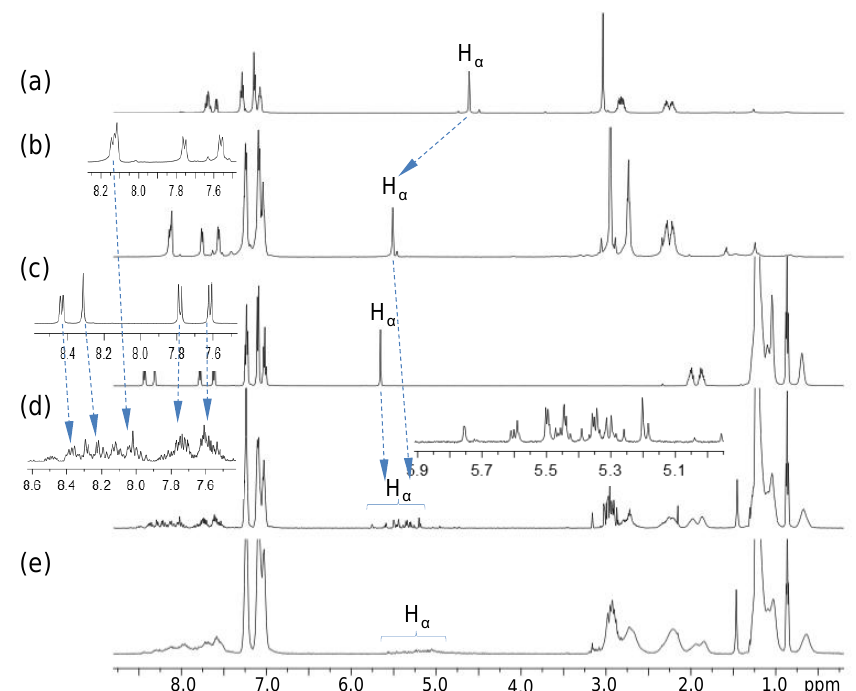
Figure 3. 1 H-NMR spectra (CDCl ( c ) C (>DPAF-C ) 1 , ( d ) C 60 18 (>CPAF-C ) 4 2M 2